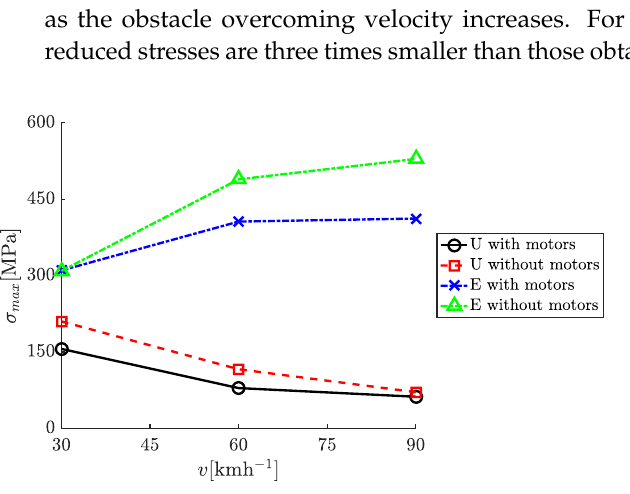
Figure 19. Relationship between maximum reduced stresses and obstacle overcoming velocity.